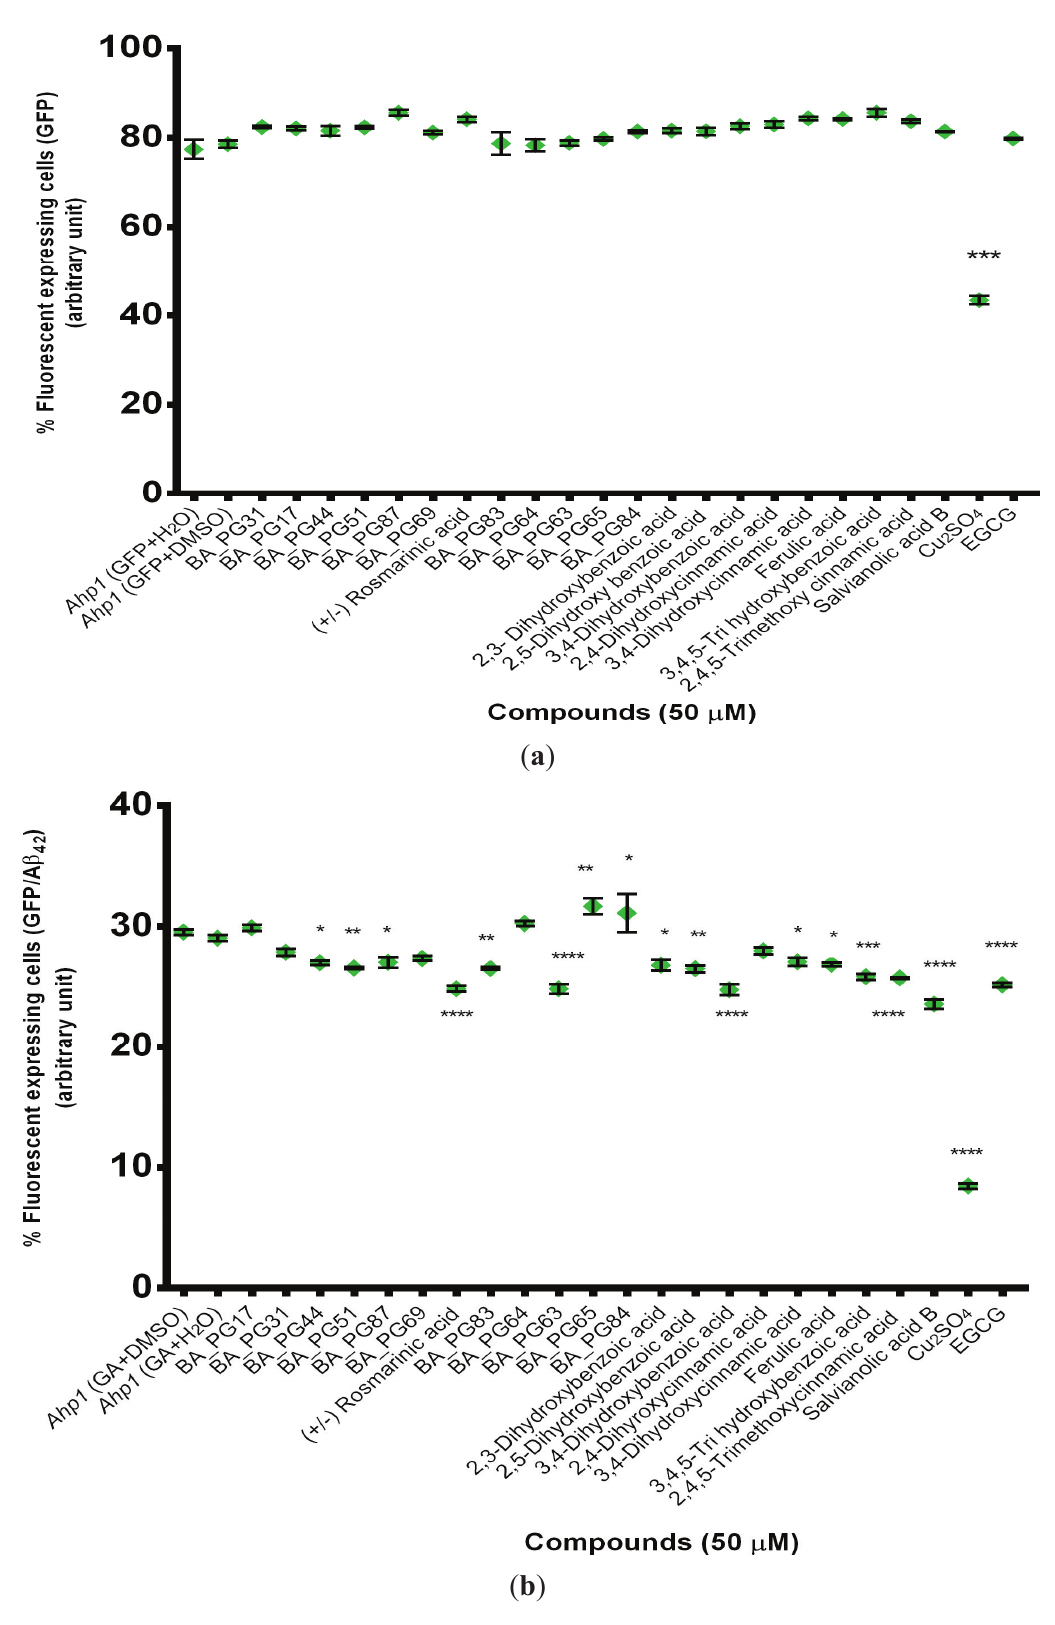
Figure 3. ( a ) Flow cytometry analysis of transformants of Ahp1 strain with GFP and ( b ) GFP-A(cid:2) 42 in the presence of polyphenolic